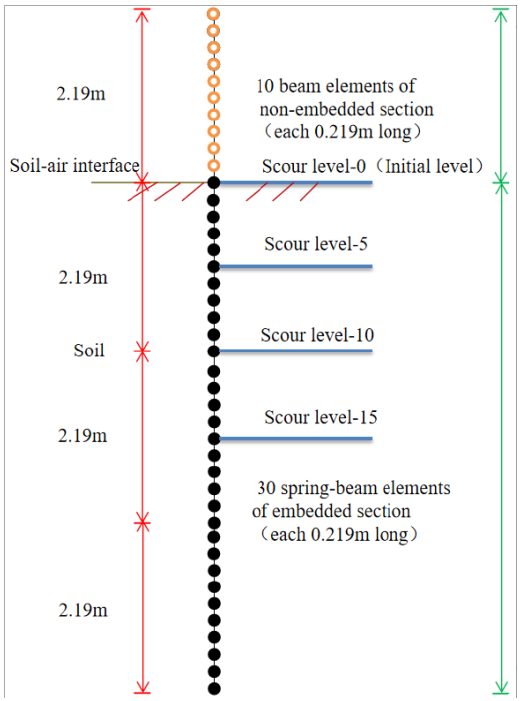
Figure 3. Numerical model of the finite difference method and setting of scour levels.